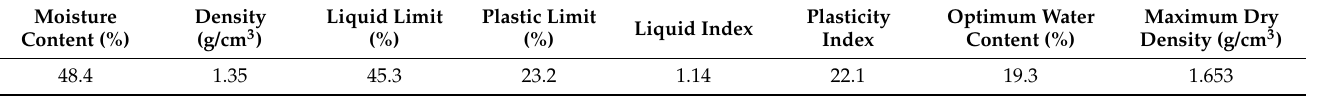
Figure 2. Dry powder. Table 1. Physical properties of waste drilling fluid.